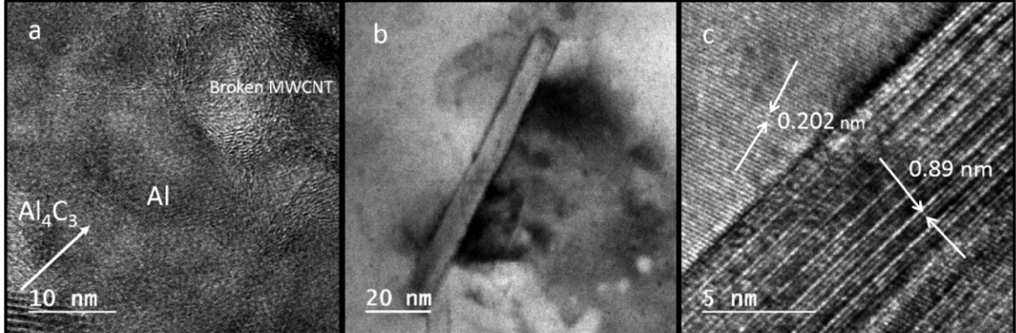
Figure 16. HRTEM bright-field images of the transverse section of the extruded strip 7075-1 wt.% composite showing ( a ) MWCNTs integrated into the 7075 aluminium matrix, ( b ) Al 4 C 3 nanorod and ( c ) magnification of the Al 4 C 3 /matrix showing lattice spacing.